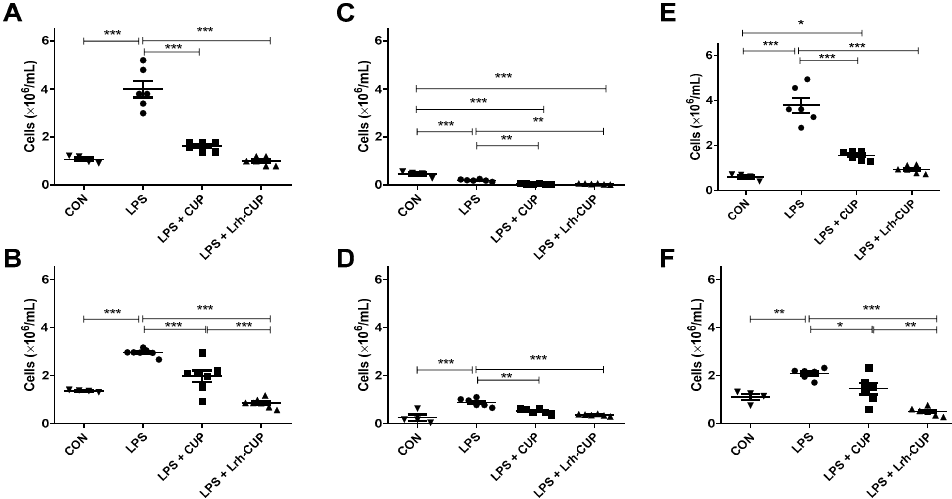
Figure 6. Effects of fermented and unfermented Theobroma grandiflorum juice in leukocytes population in the blood of mice submitted to LPS-mediated endotoxemia. ( A ) Total leukocytes in the peritoneal cavity after 6 h of LPS-mediated endotoxemia; ( B ) Polymorphonuclear leukocytes in the peritoneal cavity after 6 h of LPS-mediated endotoxemia; ( C ) Mononuclear cells in the peritoneal cavity after 6 h of LPS-mediated endotoxemia; ( D ) Total leukocytes in the peritoneal cavity after 120 h of LPS-mediated endotoxemia; ( E ) Polymorphonuclear leukocytes in the peritoneal cavity after 120 h of LPS-mediated endotoxemia; ( F ) Mononuclear cells in the peritoneal cavity after 120 h of LPS-mediated endotoxemia. * Significant differences with p < 0.05; ** Significant differences with p < 0.01; *** Significant differences with p < 0.0001. LPS: mice submitted to LPS-mediated endotoxemia; LPS + CUP: mice treated with unfermented T. grandiflorum juice and submitted to LPS-mediated endotoxemia; LPS + Lrh-CUP: mice treated with L. rhamnosus -fermented T. grandiflorum juice and submitted to LPS-mediated endotoxemia.